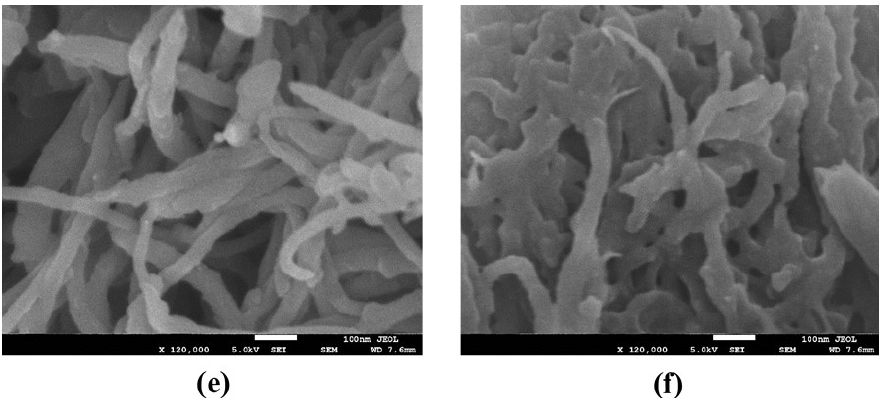
Figure 2. ( a ) XPS spectrum, ( b ) N1s deconvoluted analysis, and FESEM images of PAni ( c , d ), PAni- CNT ( e ), and GA@PAni-CNT ( f